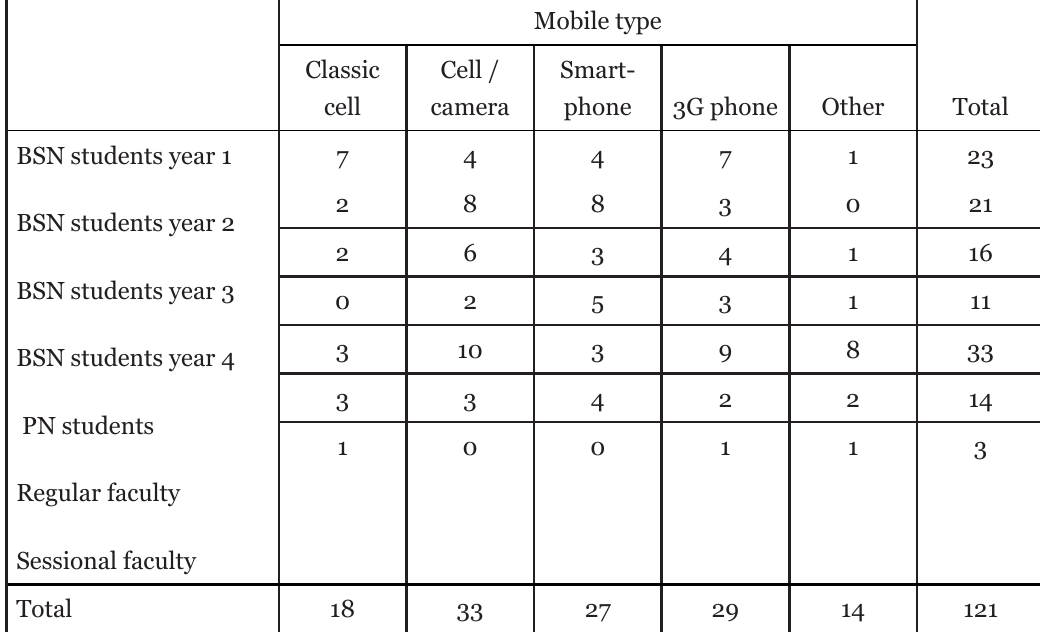
Mobile type TotalClassic Cell / Smart - cell camera